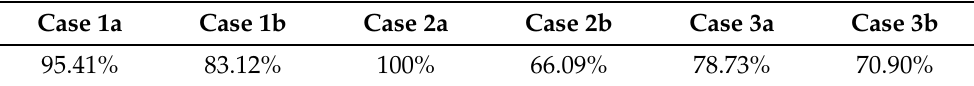
Figure 12. Comparison of SAPFs solutions, using pre-selection tool. Table 7. Plot areas of each case in Figure